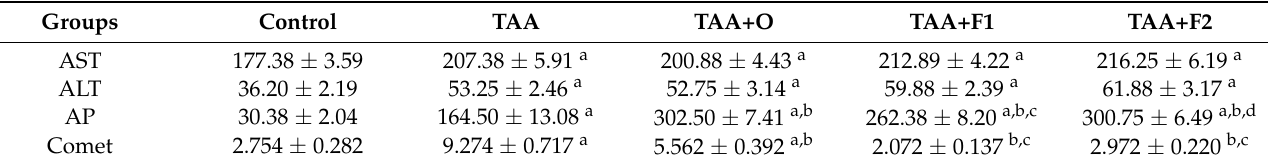
Significantly different: a in respect to Control; b in respect to TAA; c in respect to TAA+O, and d in respect to TAA+F1 group. The number of animals per group =